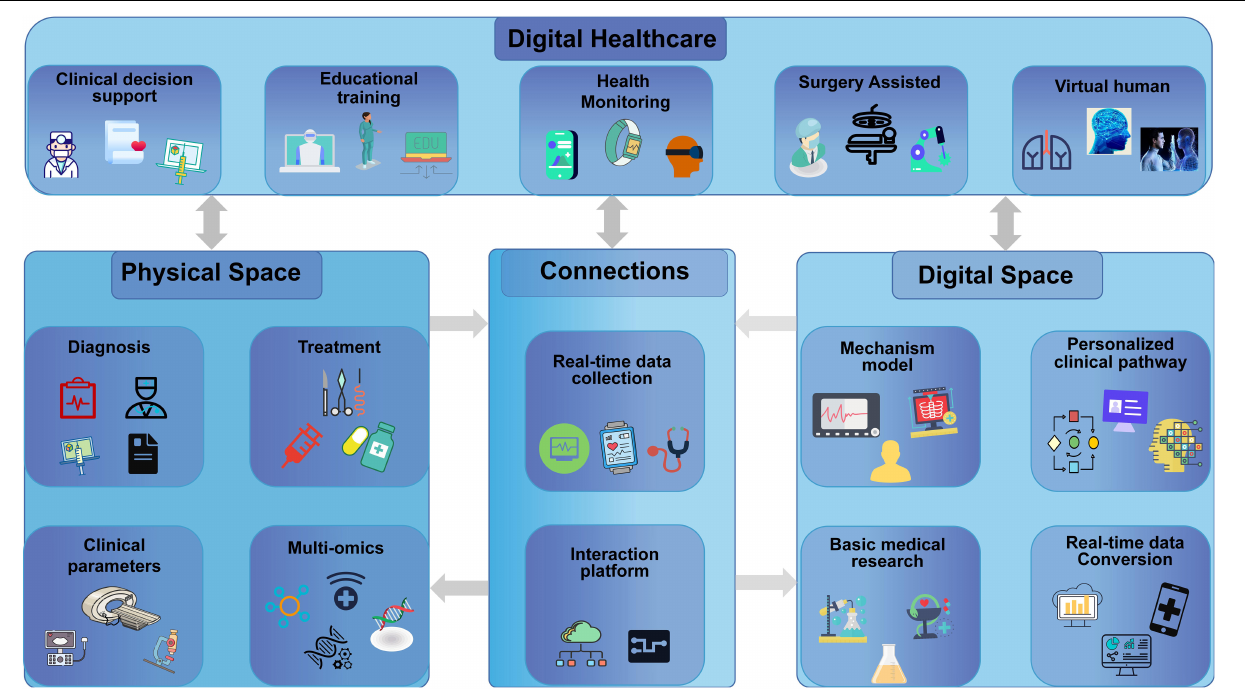
FIGURE 3 | Digital twin in the field of medicine and digital healthcare for personalized treatment.